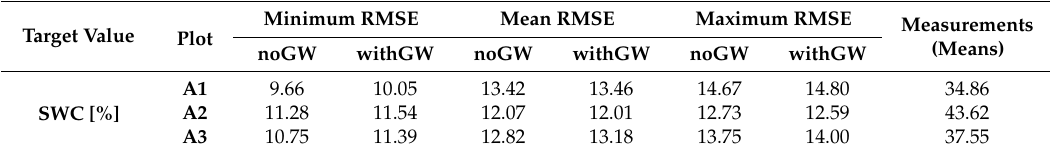
Table 6. RMSE for behavioural simulation runs of